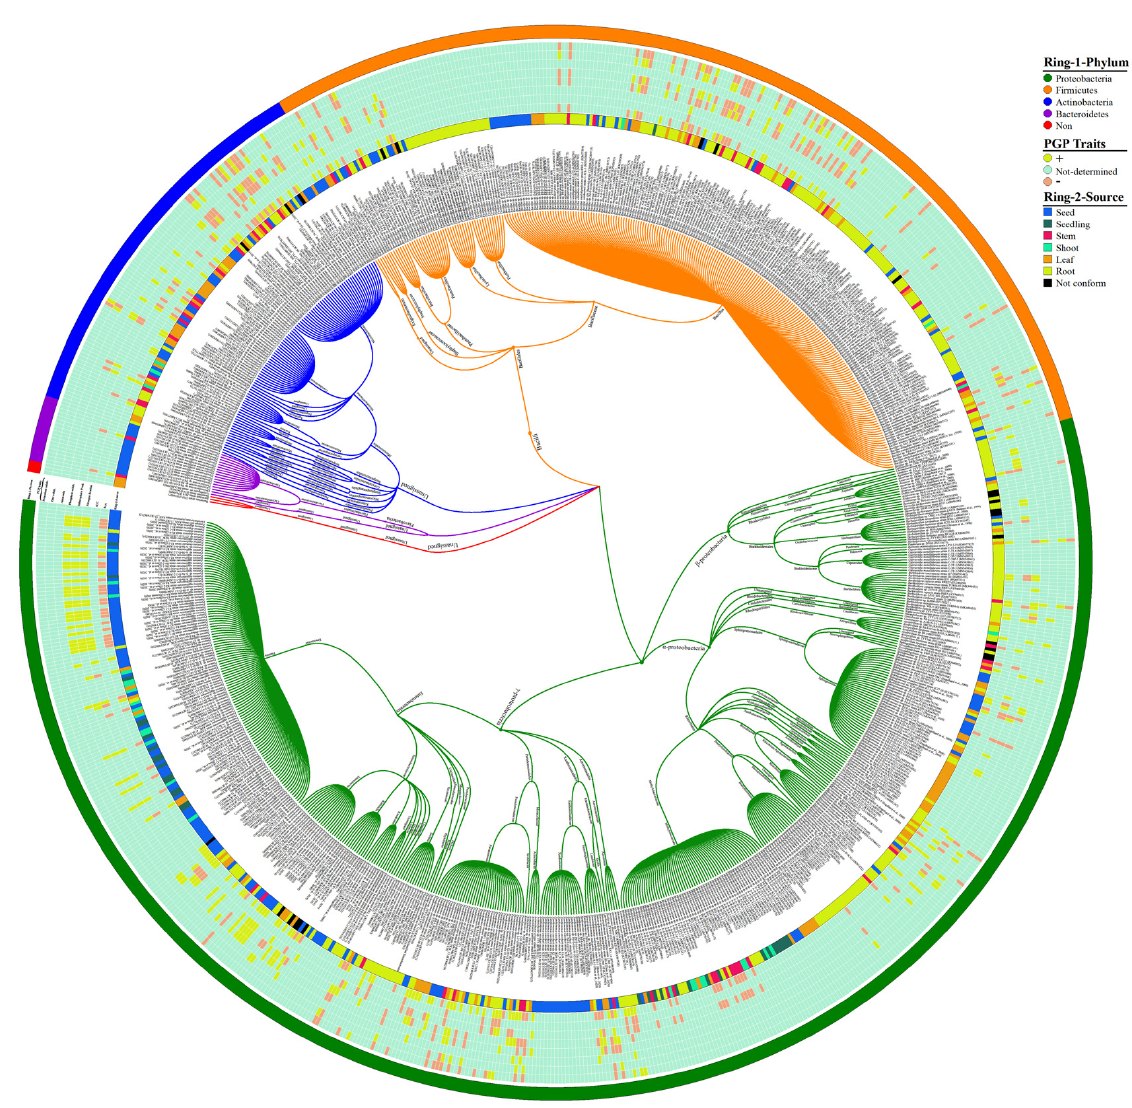
Figure 1. Rice endophytic bacterial communities. Each specified color in Ring ‐ 1 represents each phylum, and Ring ‐ 2 illustrates the source of bacterial communities from rice plants. An intermediated portion between Ring ‐ 1 and Ring ‐ 2 shows the plant ‐ growth ‐ promoting (PGP) attributes produced by rice endophytic bacterial strains; the (+) symbol indicates the presence of PGP traits, whereas the ( − ) sign indicates the absence of traits. The eight Arabic digits between in brackets indicate the accession number of the National Center for Biotechnology Information (NCBI) and references for taxonomic classification of bacterial communities (see the Supplementary Materials Data 2 for high ‐ resolution visualization of figure).